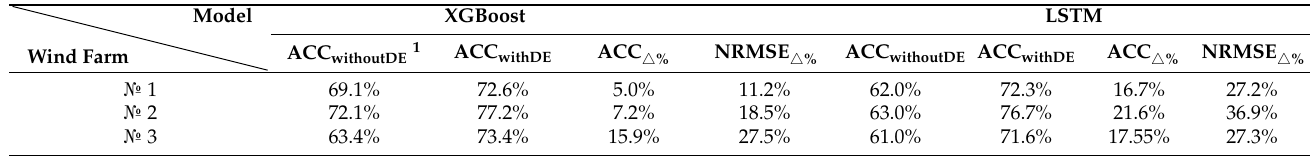
Table 5. Comparison of the forecast accuracy, accuracy improvement, and RMSE reduction in two wind energy forecasting models with and without the proposed data enrichment method for three wind farms.